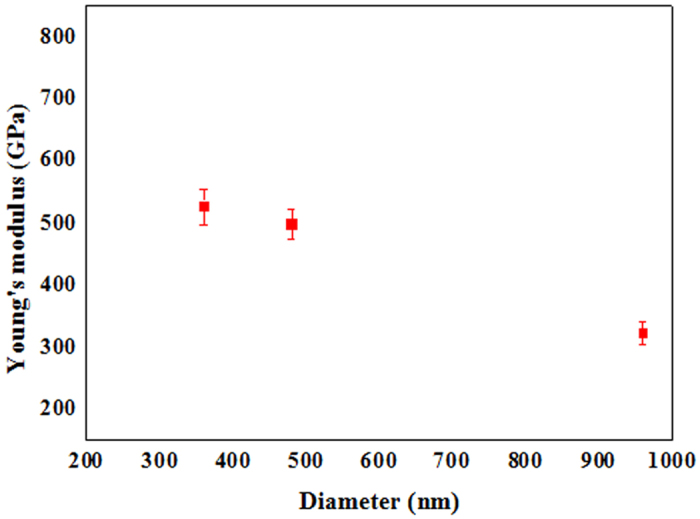
The value of Young’s modulus as a function of the diameter of the Si3N4 NWs.